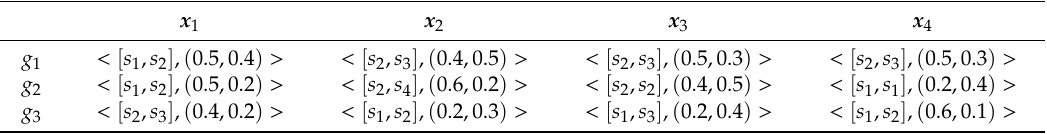
Table 1. Decision matrix A ( 1 ) with